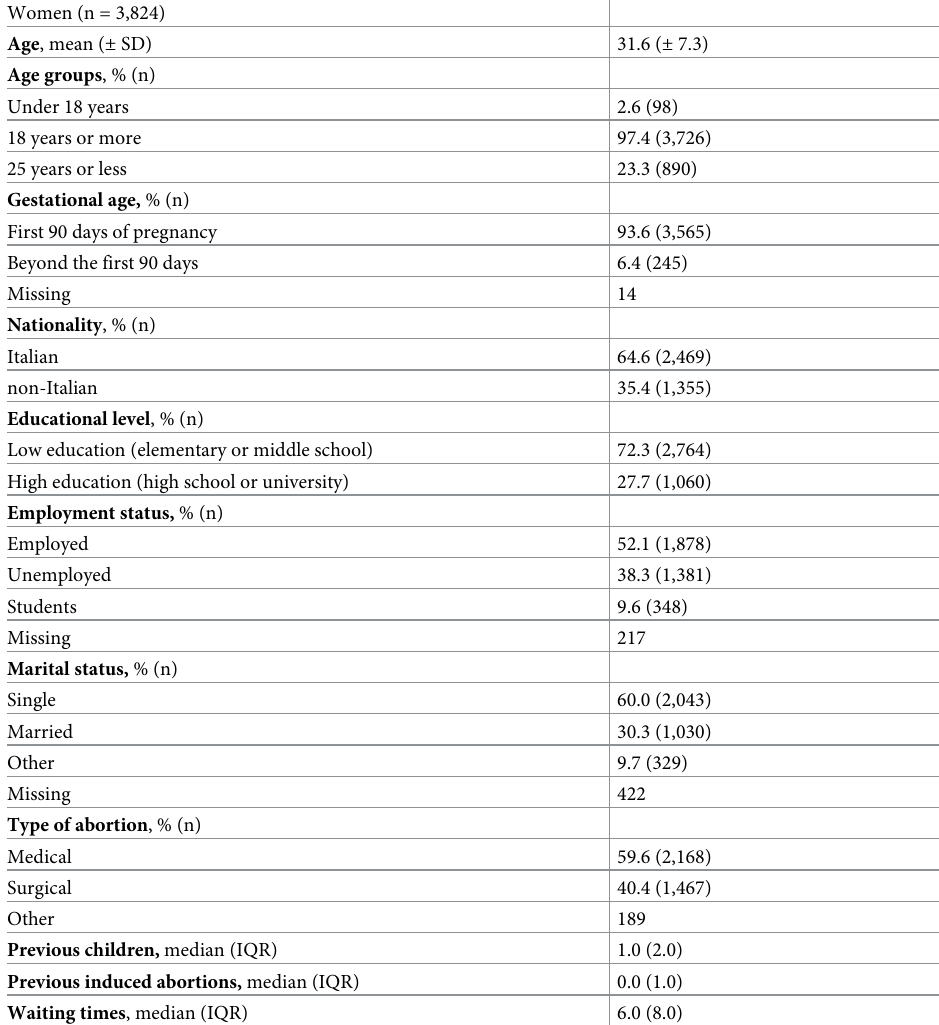
Table 1. Sociodemographic characteristics of